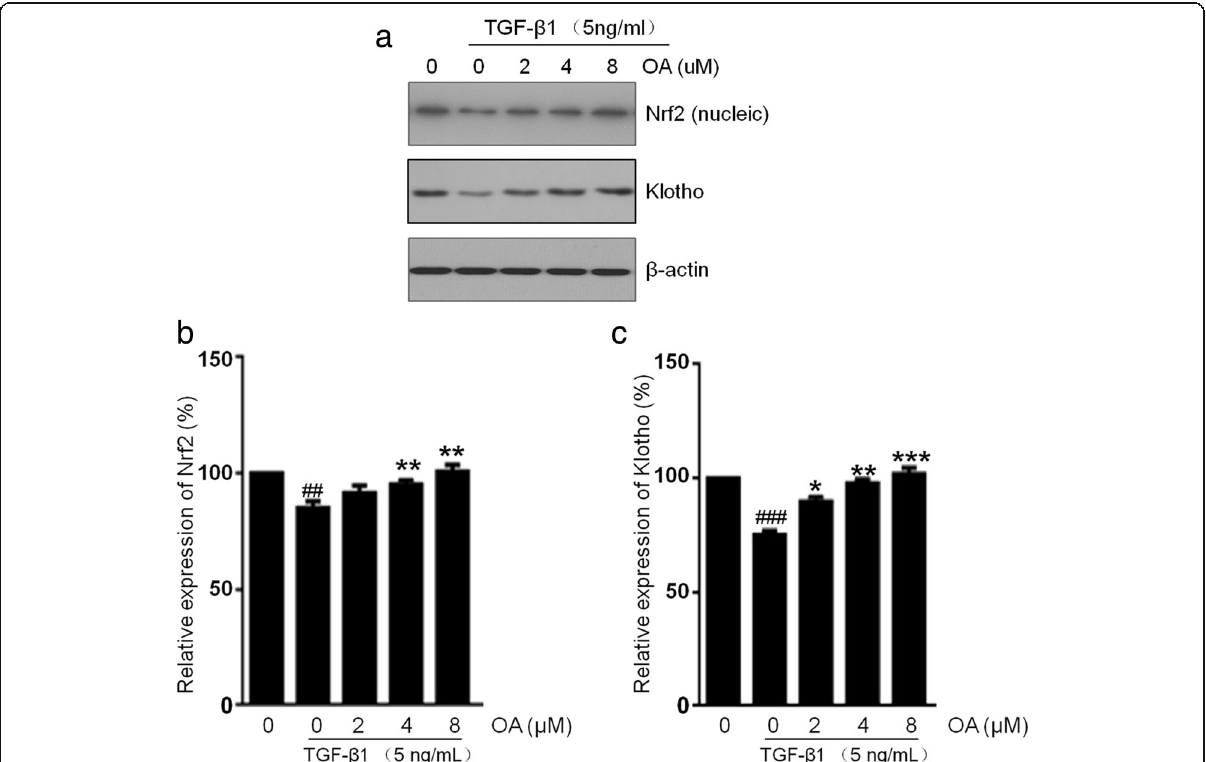
Fig. 4 Effects of OA on the Nrf2 and klotho expression in NRK-52E cells. The cells were incubated with 5 ng/mL of TGF- β 1 for 48 h with different concentrations of OA (0, 2, 4, 8 μ M). a The expression level of Nrf2 and klotho was determined by Western blotting. b , c The expression level was quantitatively analyzed with Image J software. The data showing mean±SD. # P <0.05, ## P <0.01, and ### P<0.005 vs. 0 ng/mL TGF- β 1. * P <0.05,